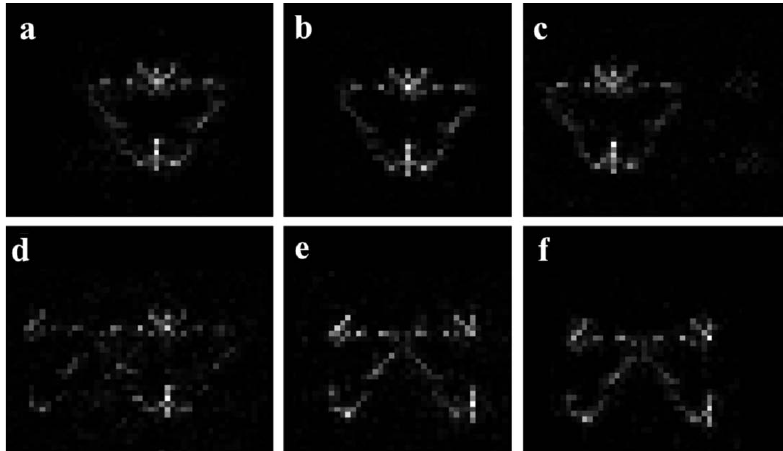
Figure 5 The real space image construction via the ab initio phase retrieval (HIO) method. The same control parameters were applied for all six cases (see Theory and methods for details). The reconstructed object from theoretical data is shown in ( a ), and ( b )–( f ) are the reconstructions from the recovered patterns shown in Figs. 4( b )–( f ),